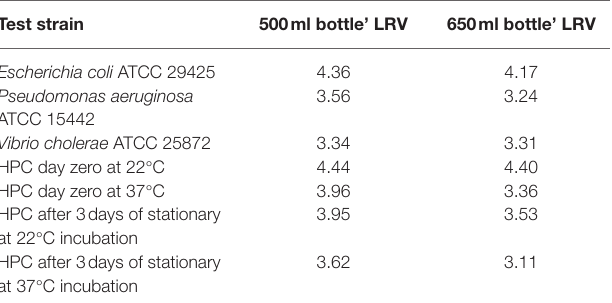
TABLE 2 | Purgaty One bottles disinfection performances against bacterial strains and environmental